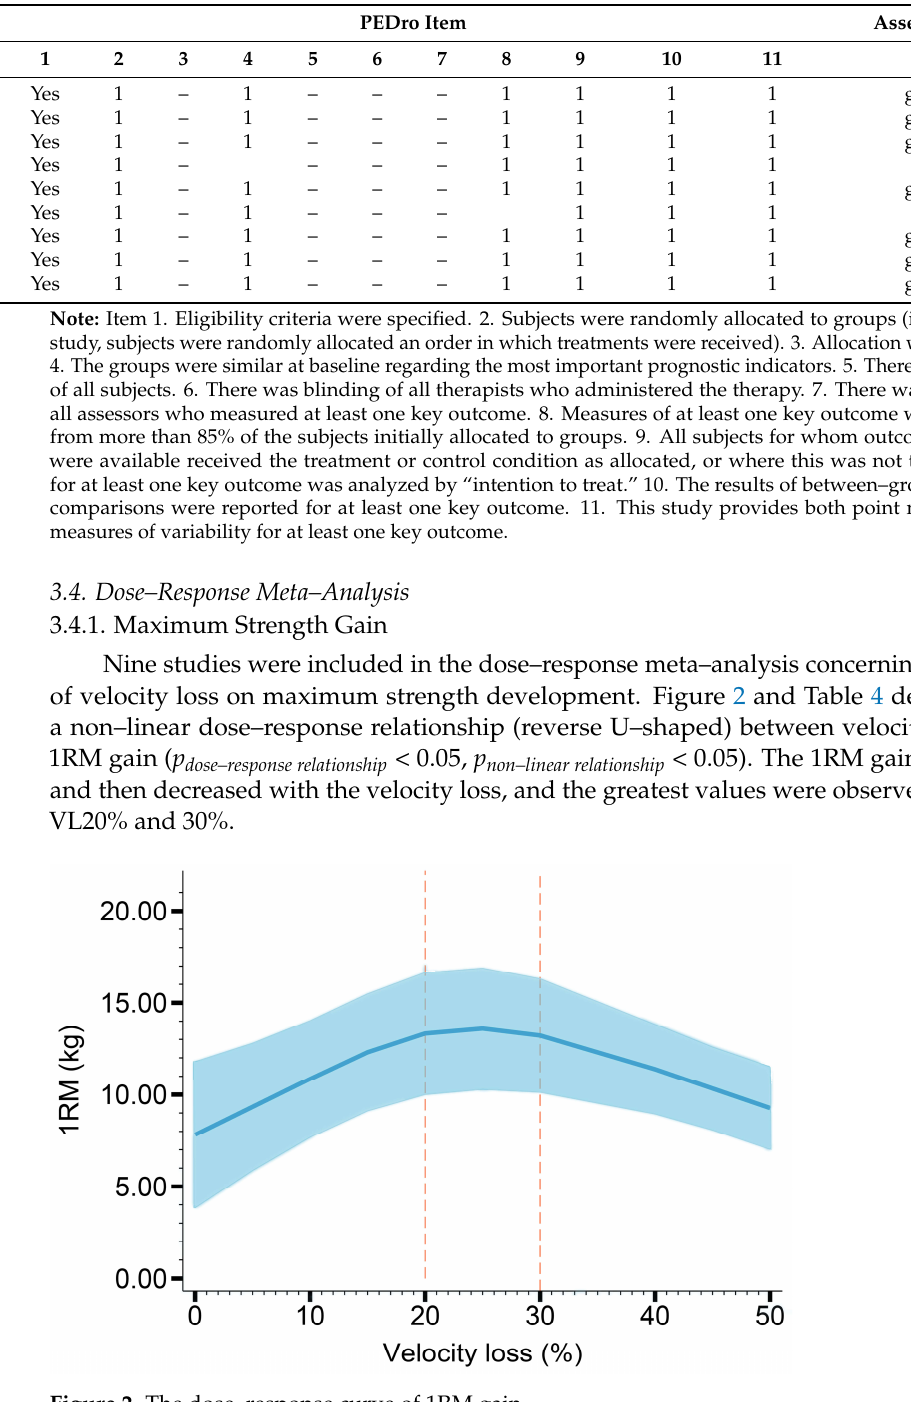
Table 3. The risk of bias assessment for the included studies.